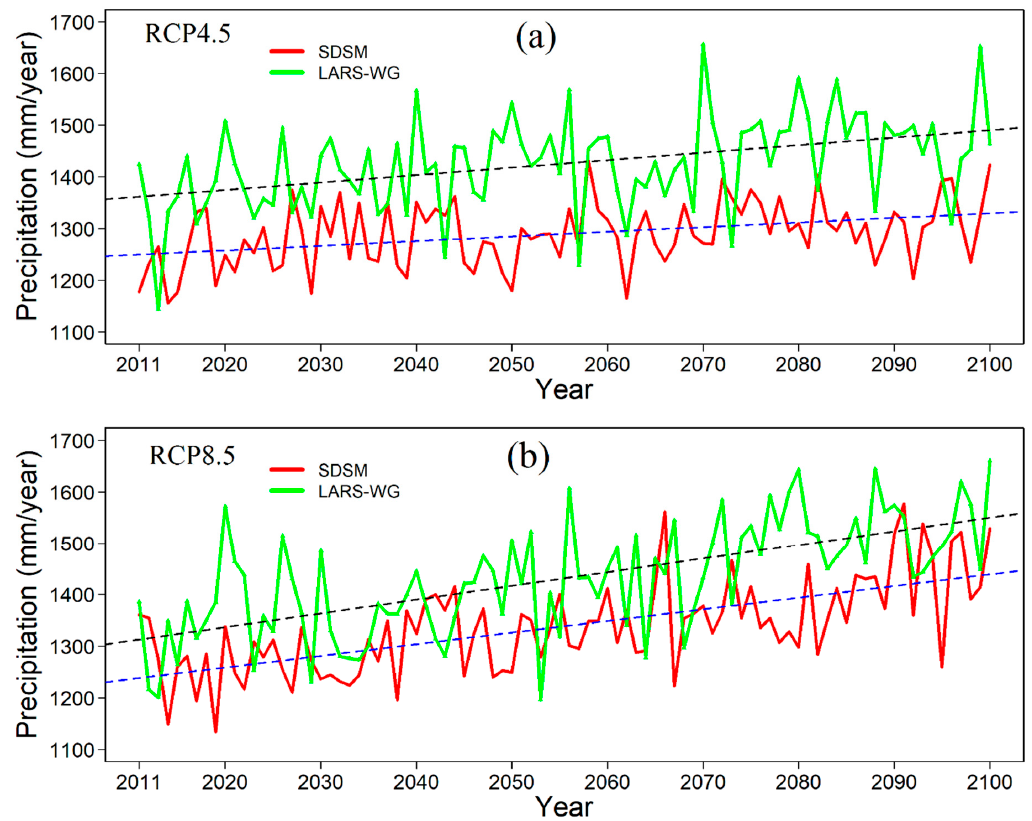
Figure 5. Total annual future precipitation trends using SDSM (Statistical Downscaling Model) and LARS-WG (Long Ashton Research Station Weather Generator) ( a ) RCP 4.5 and ( b ) RCP 8.5.